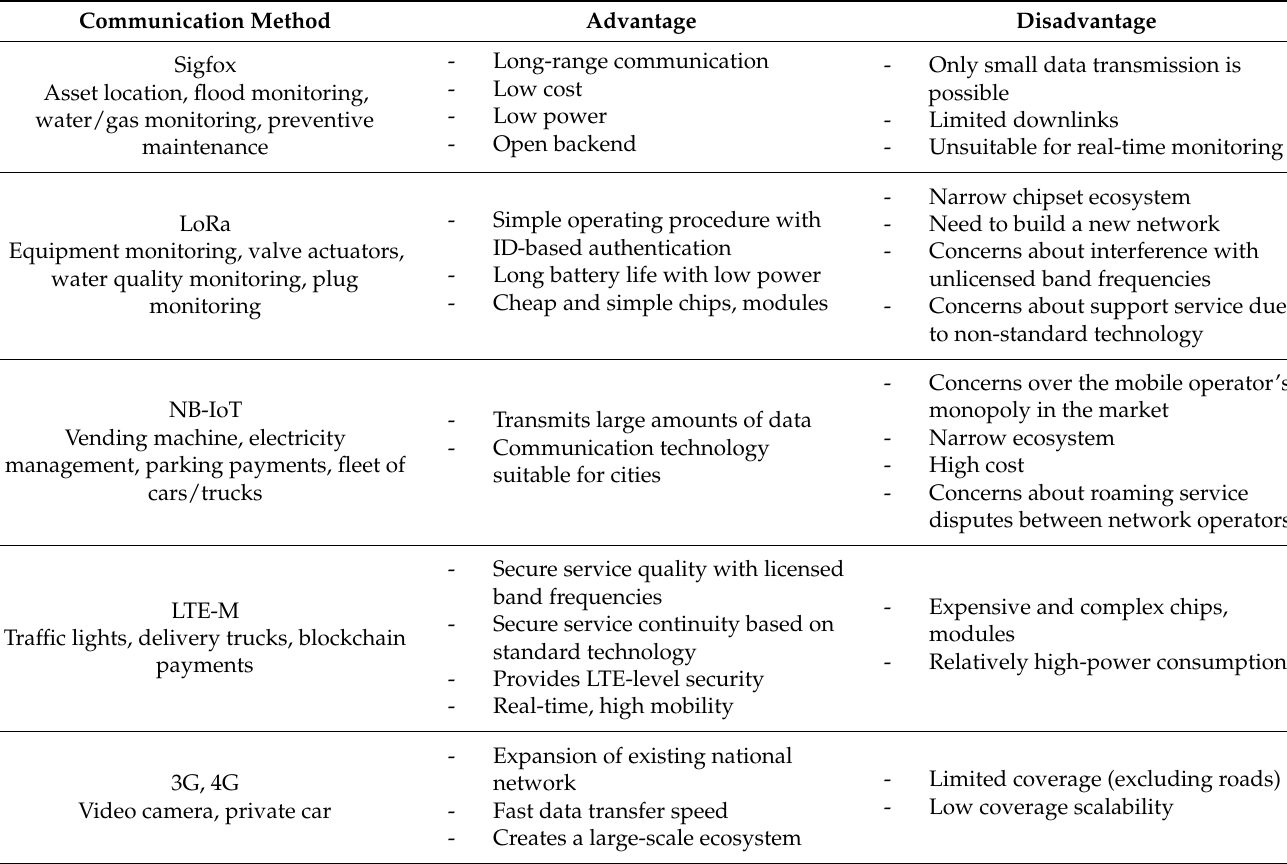
Table 1. Advantages and Disadvantages of Communication Methods